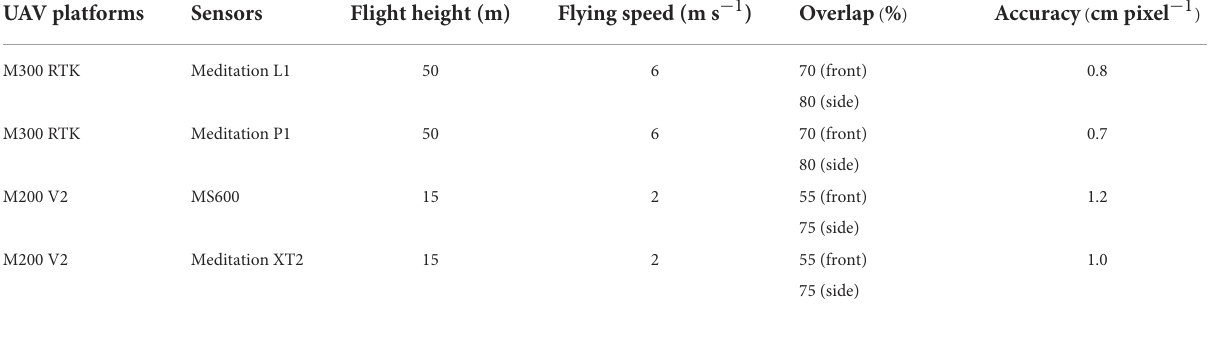
TABLE 3 Specific information on UAV systems and their flight missions.